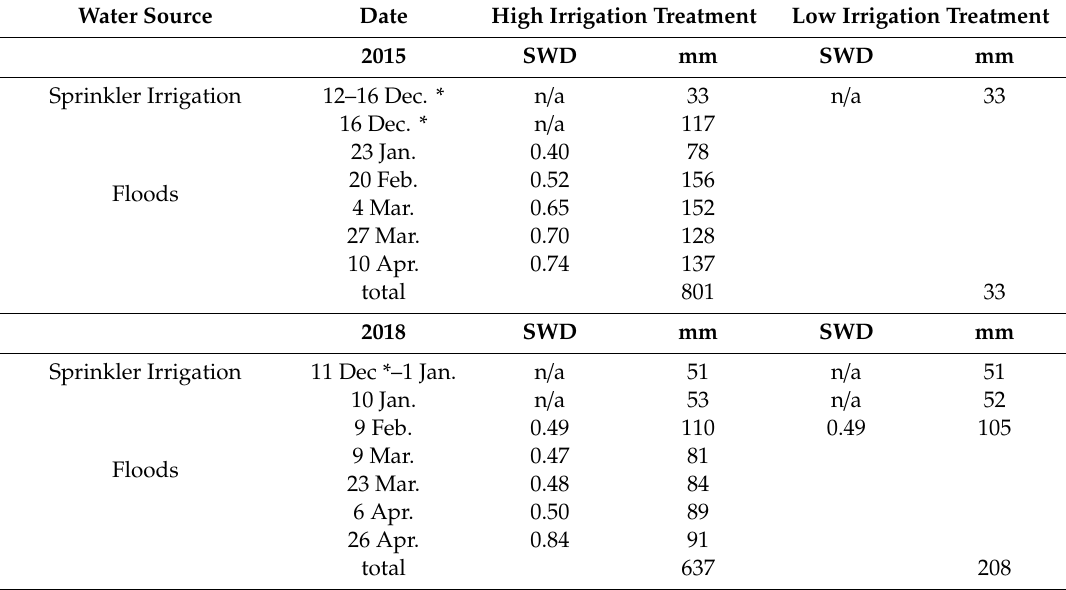
Table 1. Soil water depletion (SWD) and irrigation amounts for barley irrigation trials conducted in Tucson, AZ in 2015 and 2018. The growing season precipitation was 151 mm in 2015 and 55 mm in 2018. Water Source Date High Irrigation Treatment Low Irrigation Treatment